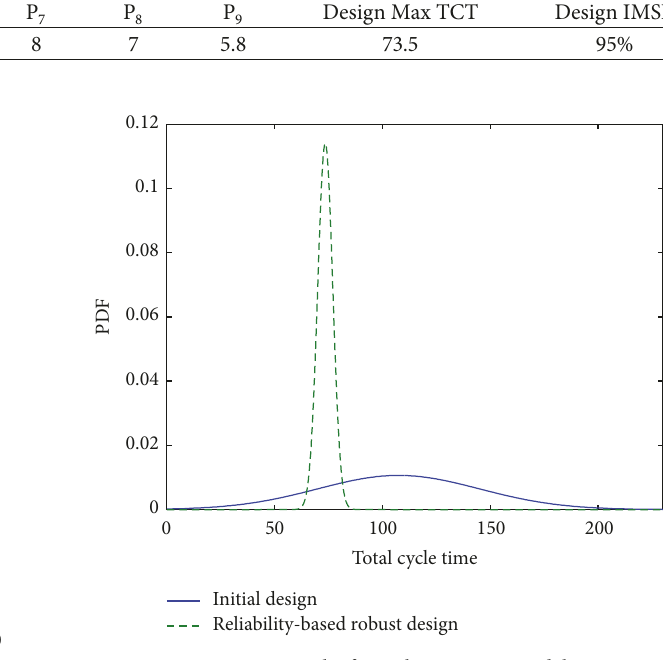
Figure 5: Results from the RBRDO